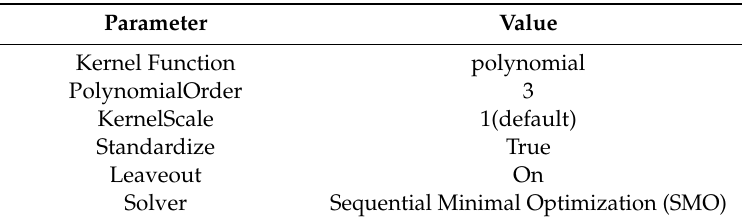
Table 2. The MATLAB configuration parameters for fitcsvm